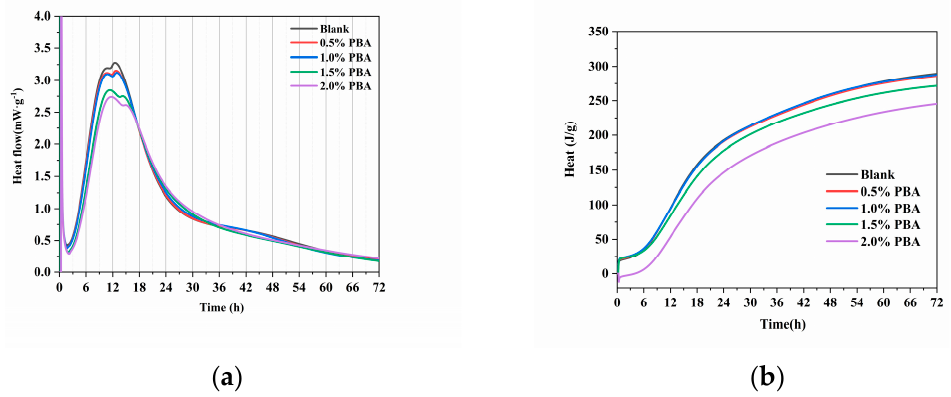
Figure 5. E ff ect of sugars on the heat fl ow curve of cement hydration. ( a ) Hydration heat rate. ( b ) Figure 5. Effect of sugars on the heat flow curve of cement hydration. ( a ) Hydration heat rate. Cumulative heat release curve. ( b ) Cumulative heat release curve.